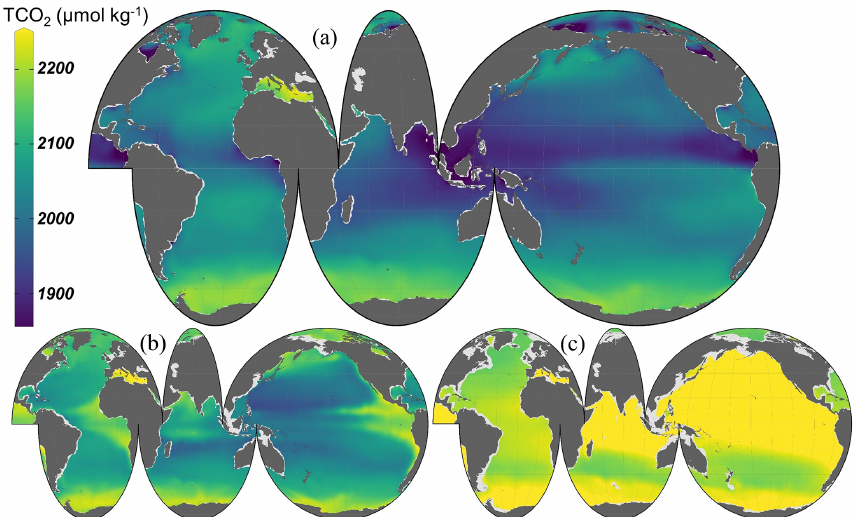
Figure 7. Annual mean climatology of TCO 2 at (a) 0m, (b) 100m, and (c) 1000m. This figure was made with Ocean Data View (Schlitzer, 2016).